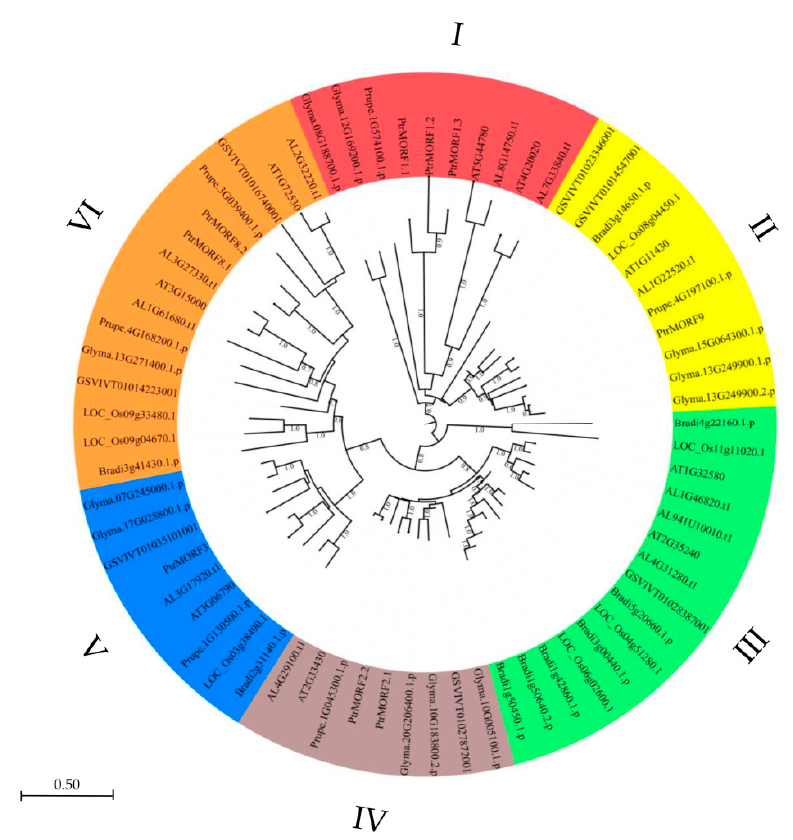
Figure 3. Phylogenetic relationships of the MORF gene family members from poplar ( PtrMORFs ) Arabidopsis lyrata , Arabidopsis thaliana , Brachypodium distachyon , Glycine max , Oryza sativa Japonica , Prunus persica , and Vitis vinifera . The phylogenetic tree was constructed with MEGA 7.0 (http://www.megasofware.net/mega.html/) program by the neighbor-joining method.